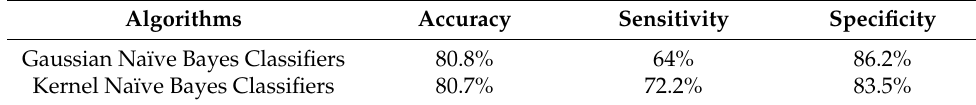
Table A2. Detailed classification performance of naïve Bayes classifiers.